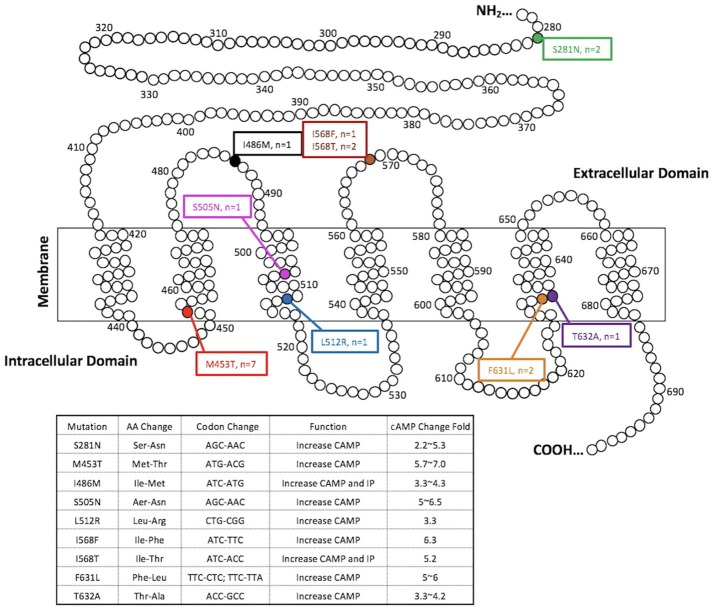
TSHR mutations detected in the present study. Functional characteristics of mutations are available at http://endokrinologie.uniklinikum-leipzig.de/tsh/frame.html.